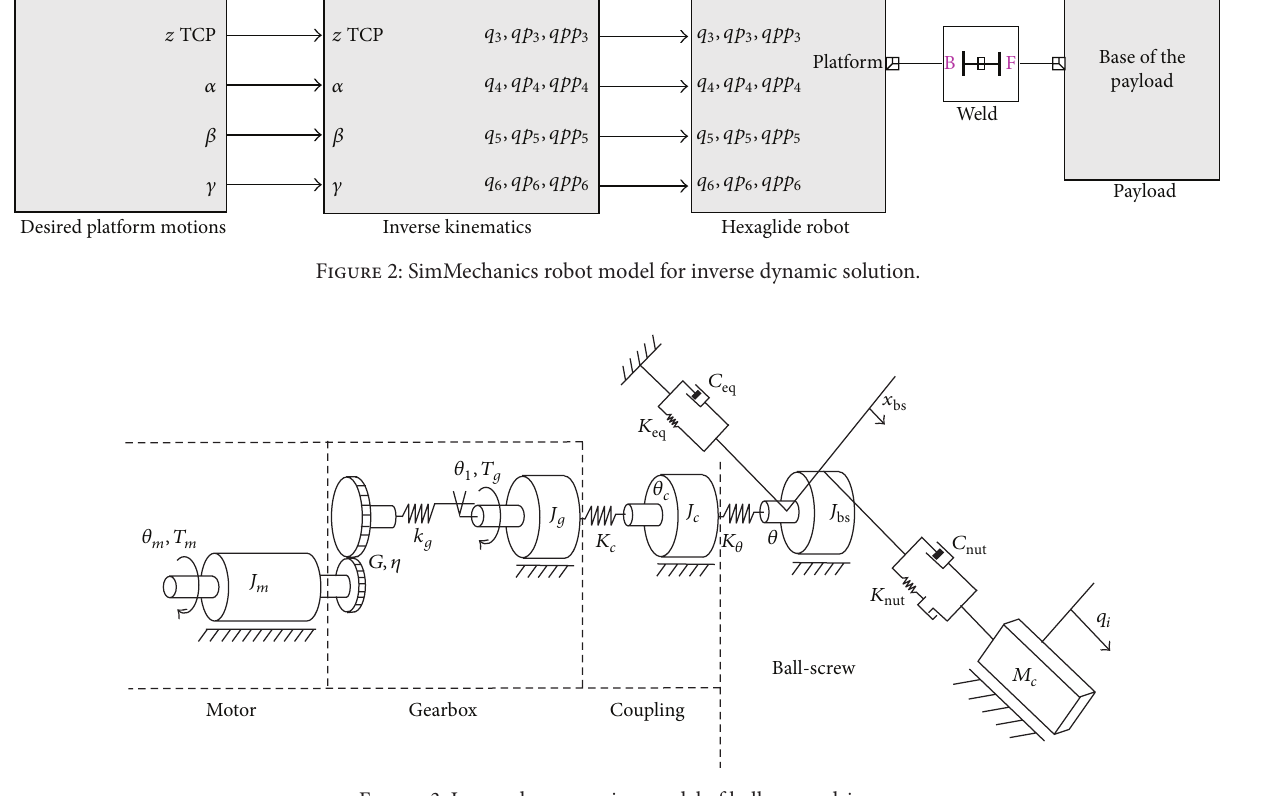
Figure 3: Lumped mass-spring model of ball-screw